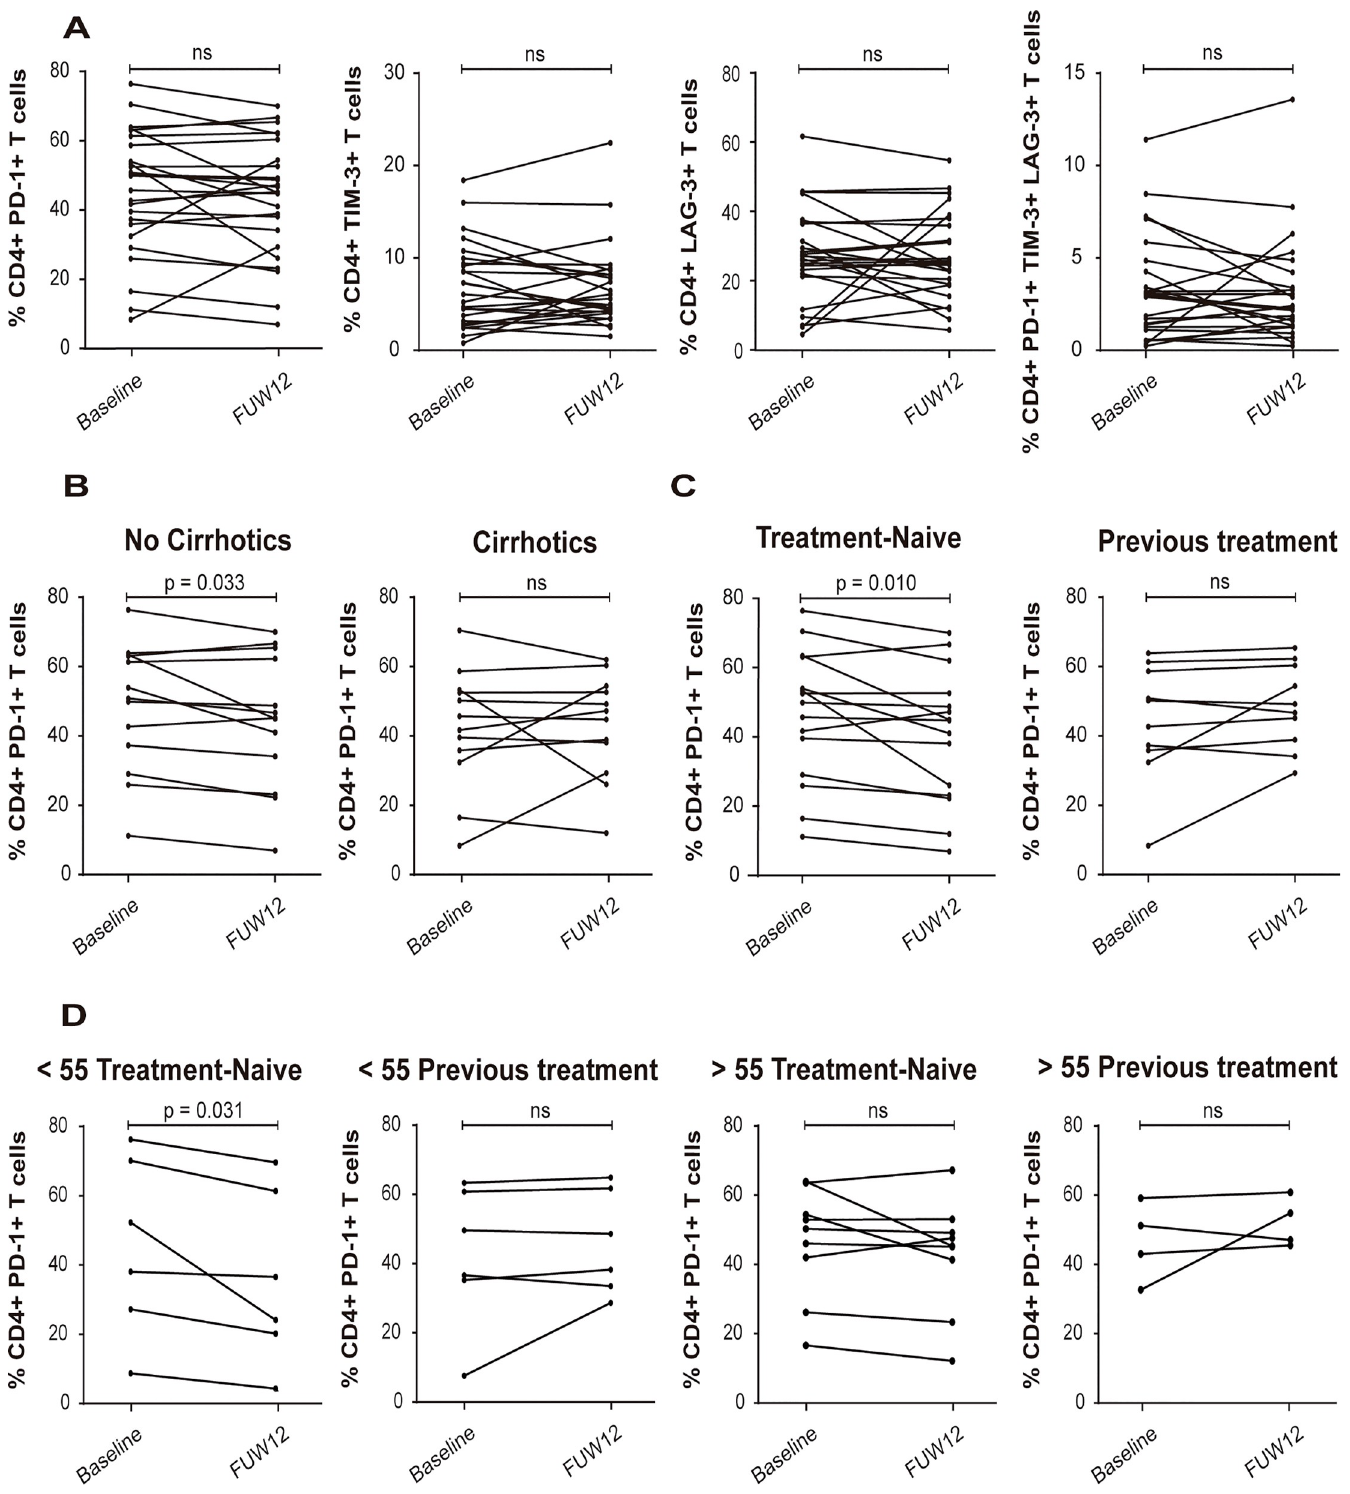
Fig 1. CD4+ T cell exhaustion markers expression. (A) Analysis of the frequencies of PD-1, TIM-3, LAG-3 markers among CD4+ T cells at baseline and FUW12, (N = 25). (B) Percent of PD-1 among CD4+ T cells according to score fibrosis. Non cirrhotic patients (N = 13), liver stiffness < 9.5 KPa; Cirrhotic patients (N = 12), liver stiffness � 9.5 KPa. (C) Percent of CD4+ PD-1+ T cells in treatment-naive patients (N = 15), and in patients with previous IFN-based therapy (PEG-IFN- α + RBV) (N = 10). (D) Percent of CD4+ PD-1+ T cells in treatment-naive patients below 55 (N = 6), in patients below 55 with previous PEG-IFN- α + RBV treatment (N = 6), in